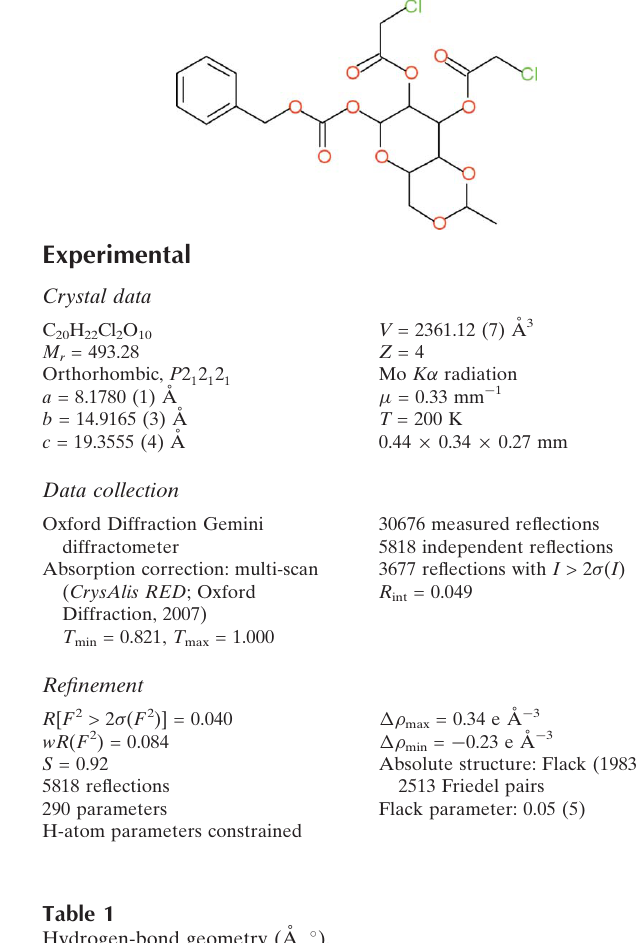
Hydrogen-bond geometry (A˚ , (cid:2) ). Cg 3 is the centroid of the C10—C15